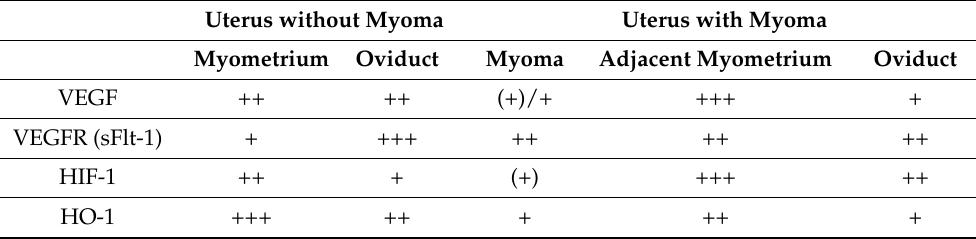
Table 1. Relative frequencies of observed angiogenic markers in the myometrial and oviductal tis- sue from the study and control groups. 0 = absence; (+) = very few; + = few; ++ = moderate density; +++ = multiple density.